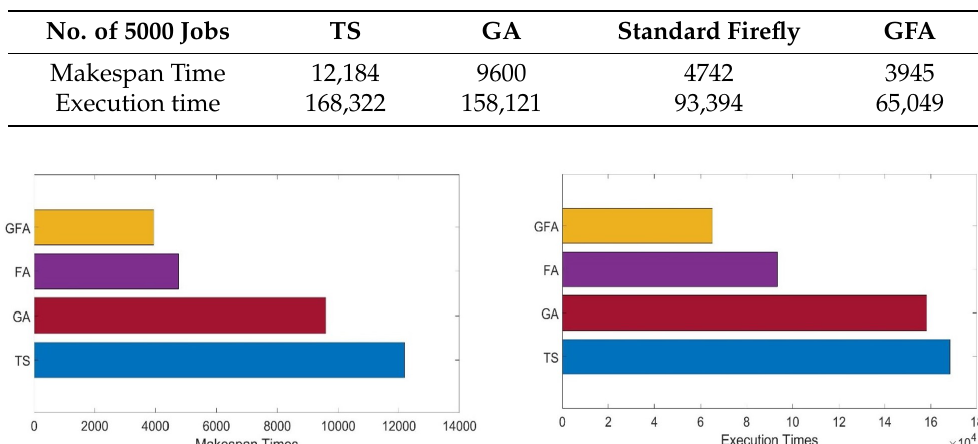
Table 7. Makespan and Execution times for Heavy Workloads.